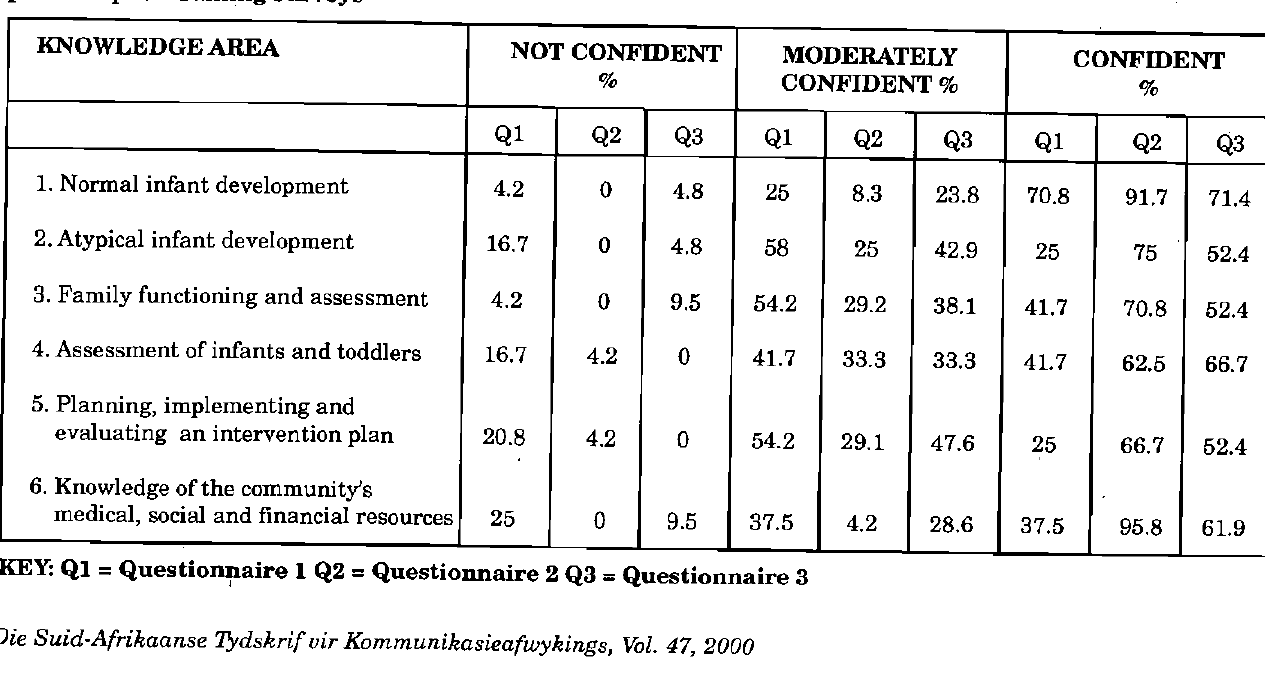
TABLE 3: Community nurses' level of confidence in th pre- and post-training